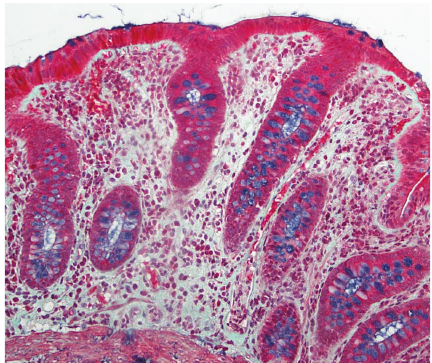
Figure 5: The colonoscopy performed 6 months after stopping lansoprazole showed that liner ulcers were completely healed and became scarred.